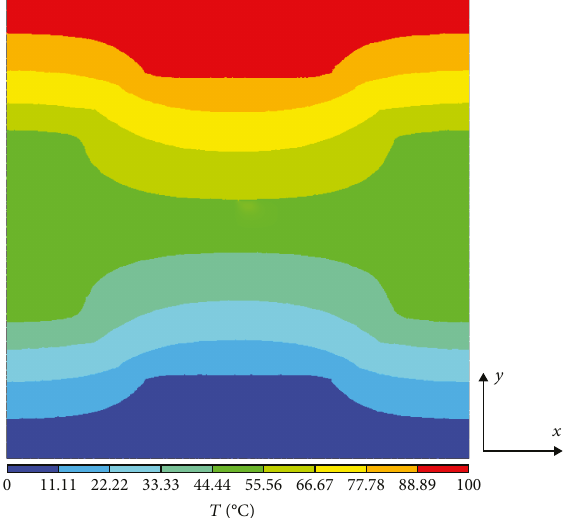
Figure 23: Pro fi le image of the temperature distribution of the crosslinked model.